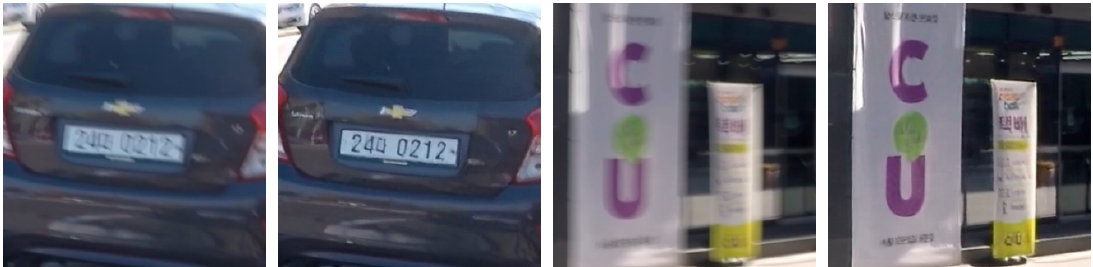
Figure 6. Partial GOPRO dataset.